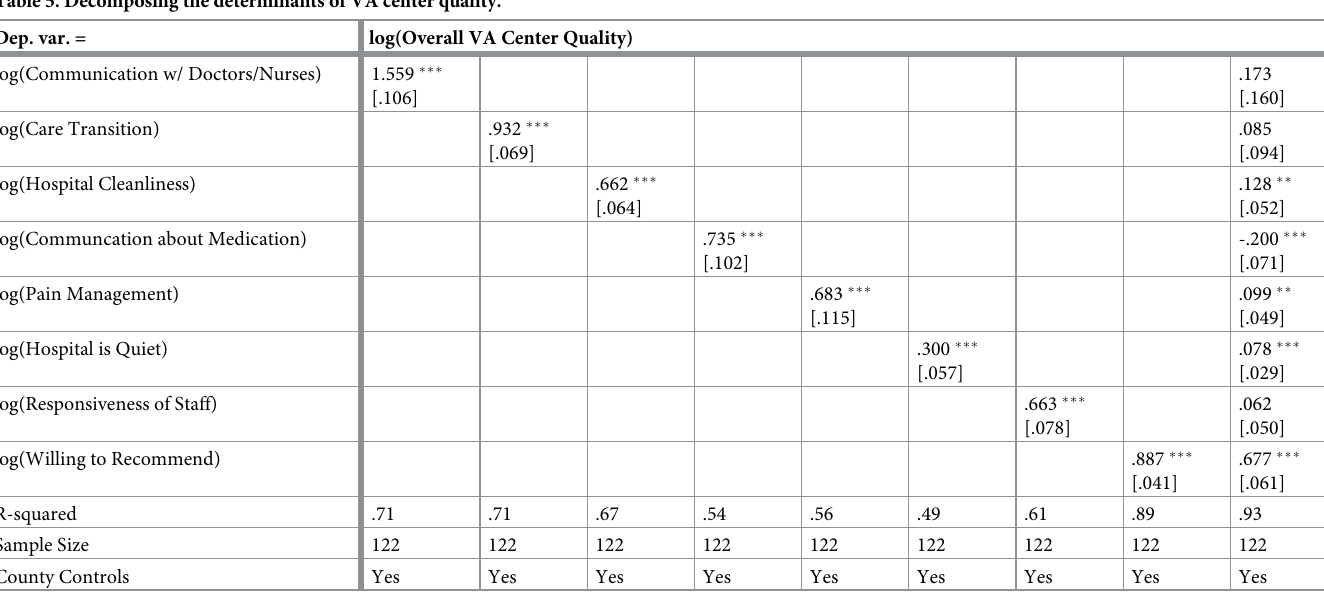
Table 5. Decomposing the determinants of VA center quality. Dep. var.